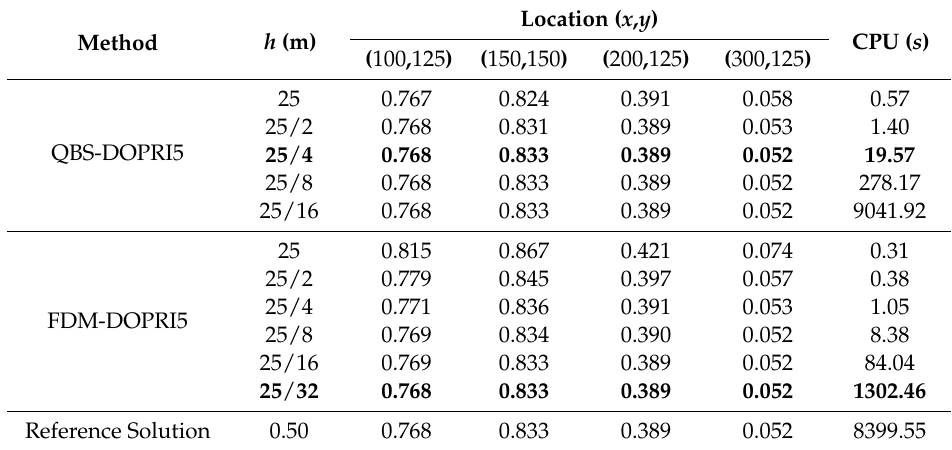
Table 7. Comparison of CPU times of QBS-DOPRI5 and FDM-DOPRI5 for different grid size and t = 200 days (Scenario A).